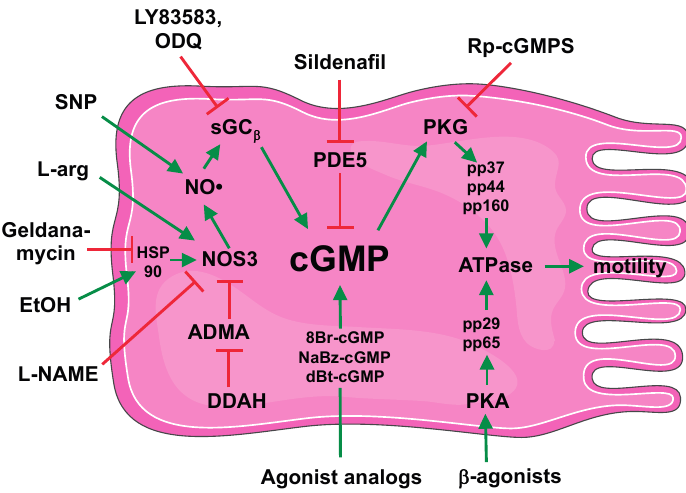
Figure 2. Schematic of cGMP action in cilia motility. Stimulation pathways indicated by green arrow-headed lines. Inhibition pathways indicated by red bar-headed lines.